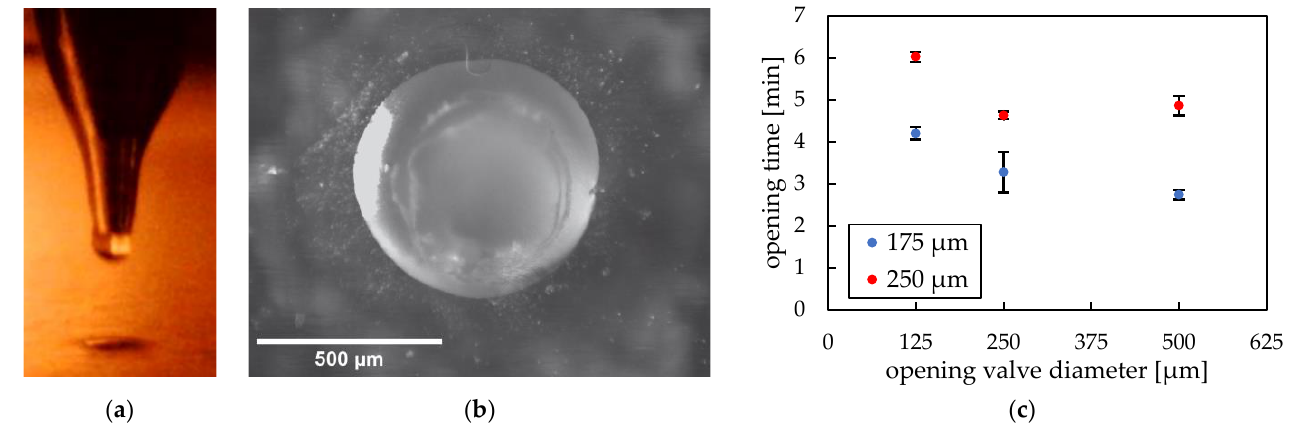
Figure 11. ( a ) Side view during pneumatic cartridge dispensing printing process, the upper part is the tip of the metallic nozzle of the pneumatic extruder and below is a 500 µm hole in a PMMA foil. ( b ) Top view of PEG printed and solidified in a hole. ( c ) Dependence of opening time on diameter of holes (d OV ) and thickness (h VS ) of PMMA foil.